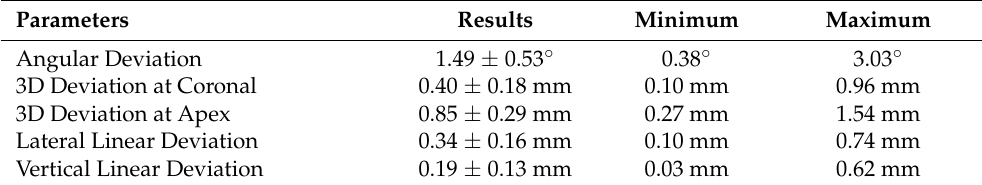
Table 1. Results of implant deviation with a variety of bone models.